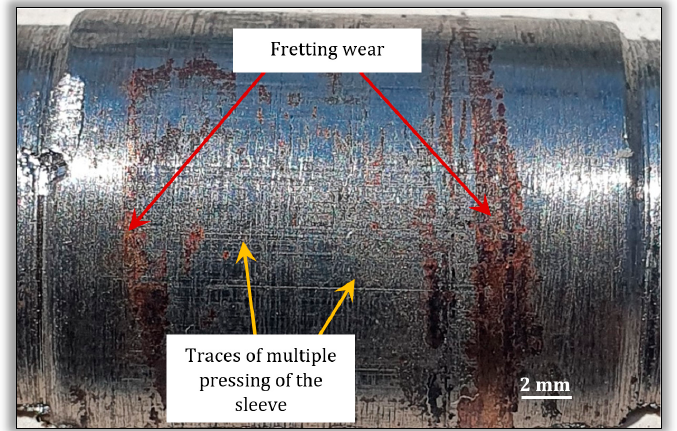
Figure 11. Macroscopic image of the shaft surface after the third fatigue cycle (1,000,000